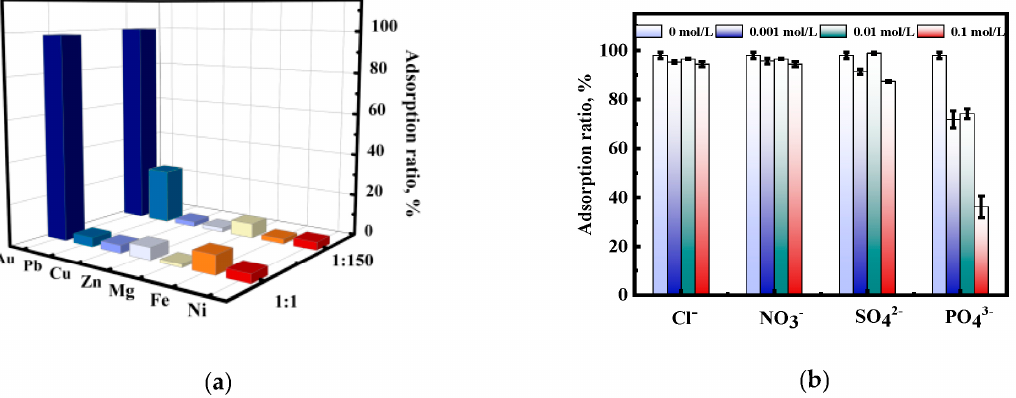
Figure 11. ( a ) Effect of coexisting metal ions on Au(III) adsorption (c Au(III) and coexisting ions = 100 mg/L, c Au(III) = 10 mg/L and c coexisting ions = 1500 mg/L); ( b ) effect of acid radical ions on Au(III) adsorption.